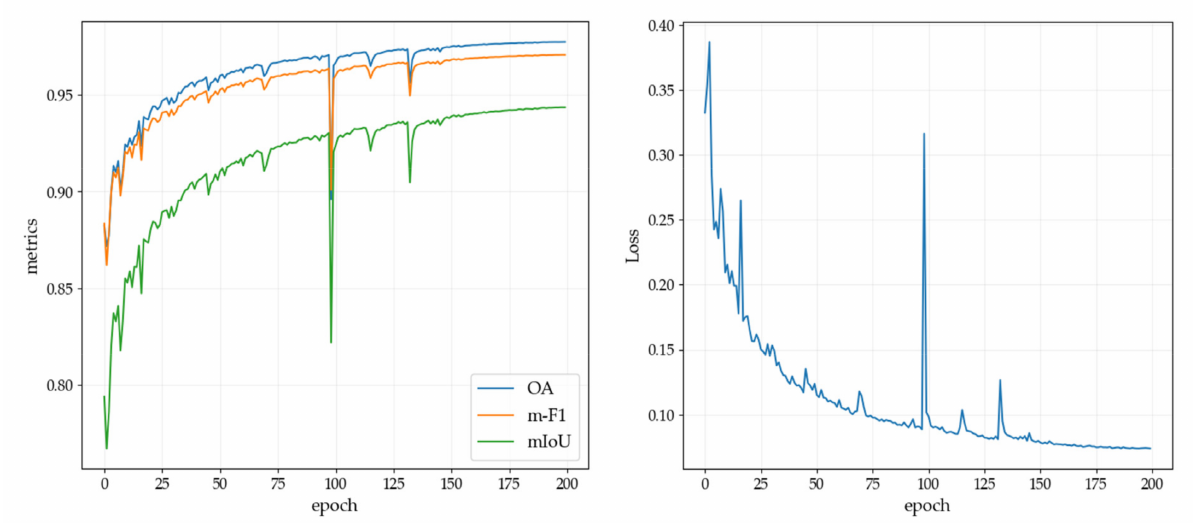
Figure 5. The variation in evaluation metrics and loss during the training phase with 200 epochs for the Potsdam validation dataset. (From left to right ) Columns reveal the process of OA, m-F1, mIoU changing with epochs, and the process of loss changing with